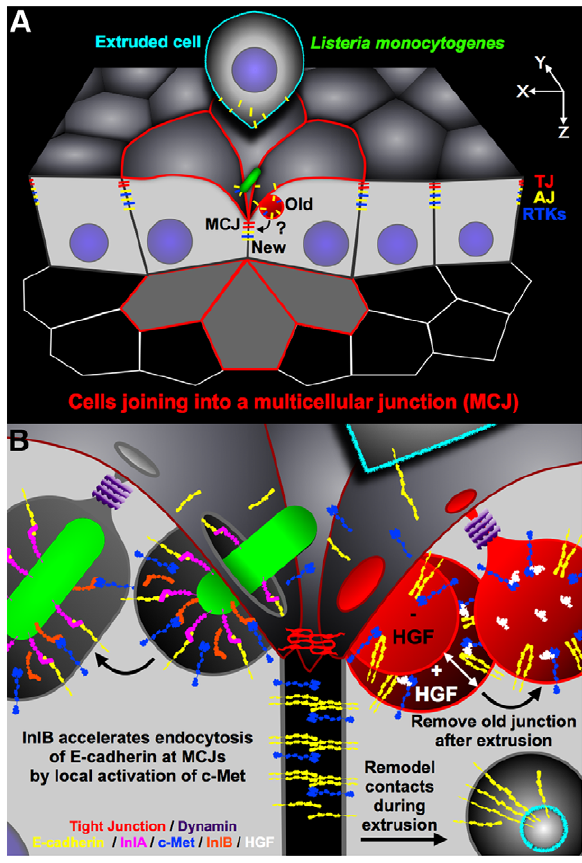
Figure 6. Diagram of Lm invasion coupled to junctional remodeling by endocytosis at the MCJ. (A) Lm find exposed E- cadherin at multicellular junctions (MCJs) when extruded cells are displaced from the epithelium. New tight junctions (TJs) and adherens junctions (AJs) are formed below the extruded cell at the invagination of MCJs. The old junctions and intercellular-adhesions are removed by endocytosis. RTKs, receptor tyrosine kinases. (B) Close up diagram of the region of bacterial invasion at the MCJ. Left: after binding to E-cadherin via InlA, InlB activates c-Met which is also abnormally exposed to the apical surface at MCJs. Activation of c-Met locally by InlB at the MCJ increases the rate of endocytosis of Lm . Right: endocytic removal of the old junctions parallels Lm uptake. Experimentally, c-Met activation by HGF may increase the rate of formation and the size of endosomes. E- cadherin, yellow; InlA, magenta; c-Met, blue; InlB, orange; HGF, white; dynamin, purple; a simplified tight junction, red.